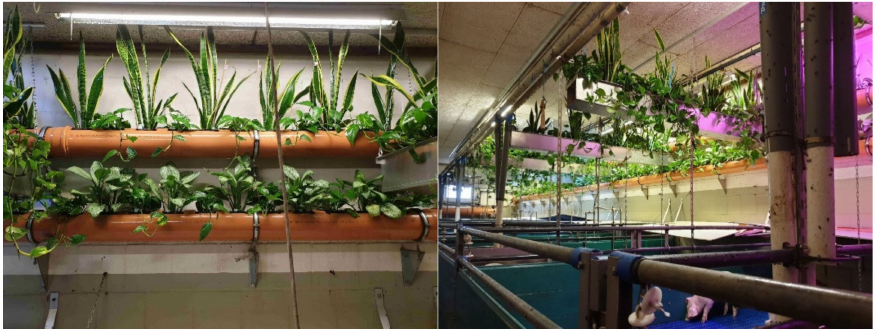
Figure 2. Plant system introduced in